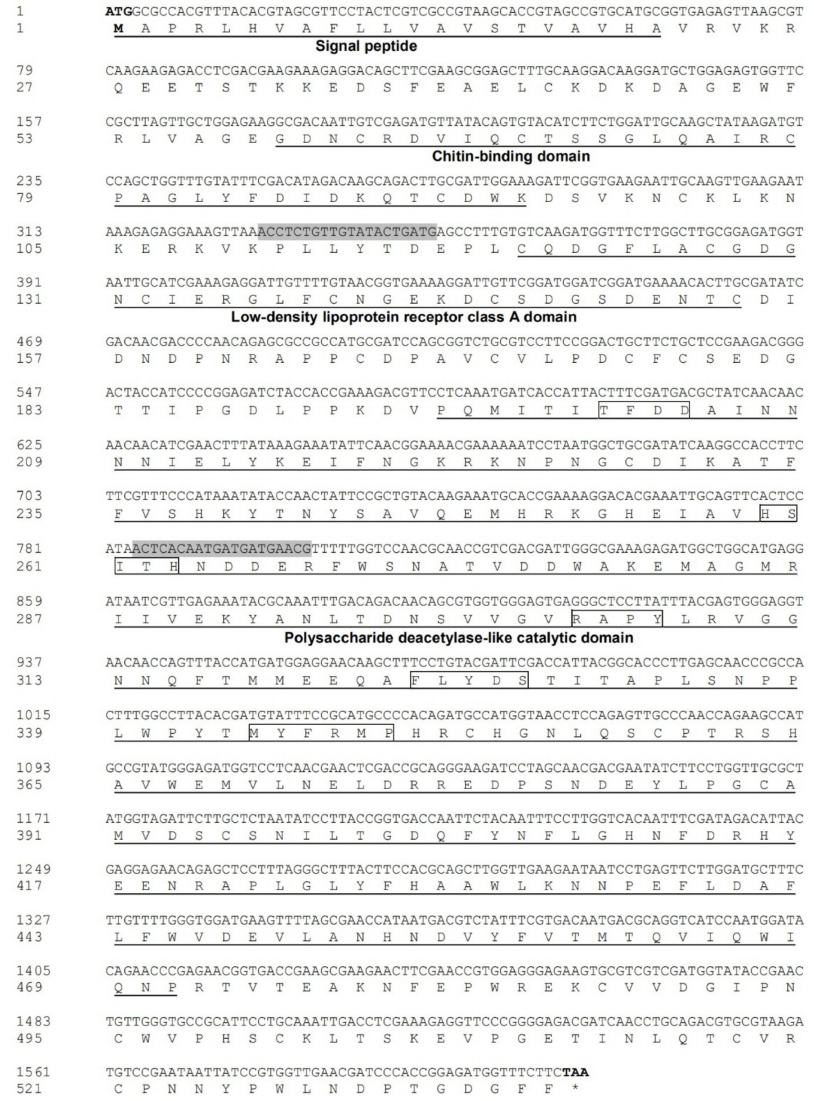
Figure 1. The nucleotide and deduced amino acid sequences of LsCDA1 cDNA. The start codon is indicated in bold and the stop codon in bold with an asterisk. The predicted signal peptide, chitin-binding domain, low-density lipoprotein receptor class A domain, and polysaccharide deacetylase-like catalytic domain are underlined. Five signature motifs (motifs 1–5) of the sequence catalytic domain are boxed. The primers for LsCDA1 dsRNA synthesis are